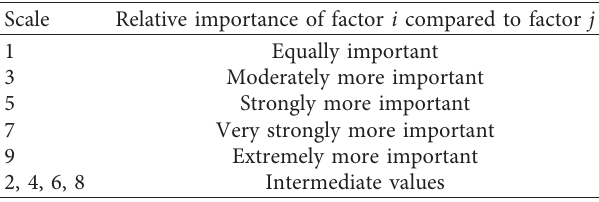
Table 6: AHP scale for criteria comparison.